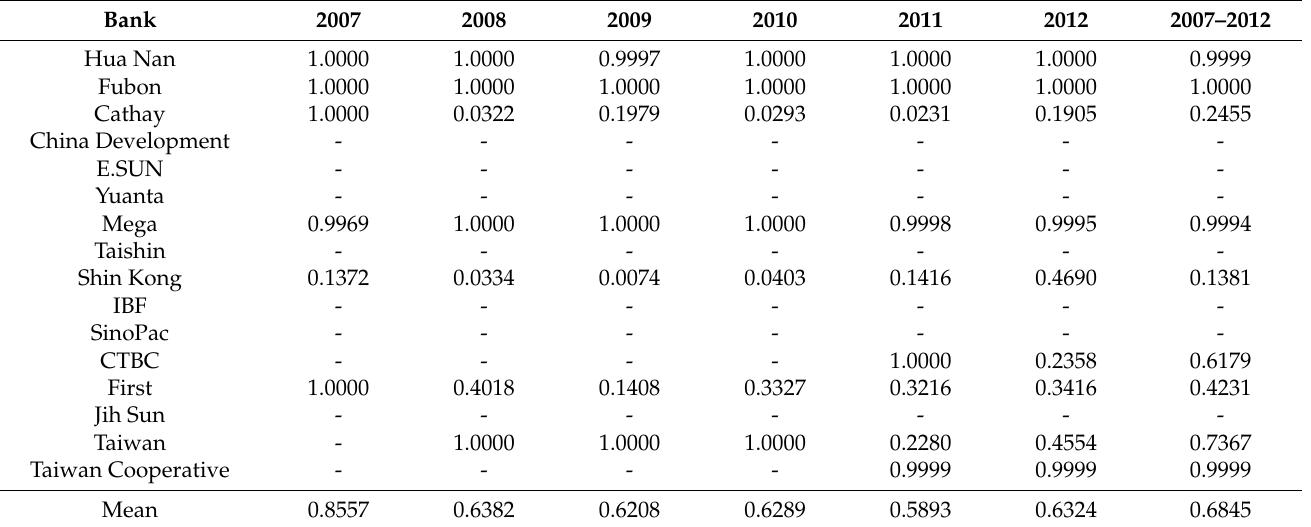
Table 10. Profitability performance for insurance service of Taiwanese FHCs obtained in Model 3.